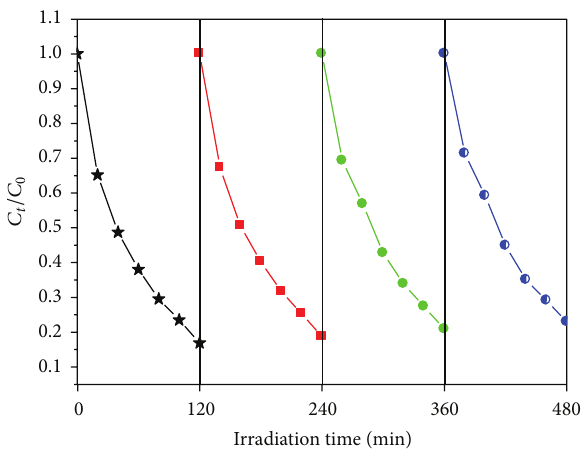
Figure 7: Recycling runs in the photocatalytic degradation of MO.